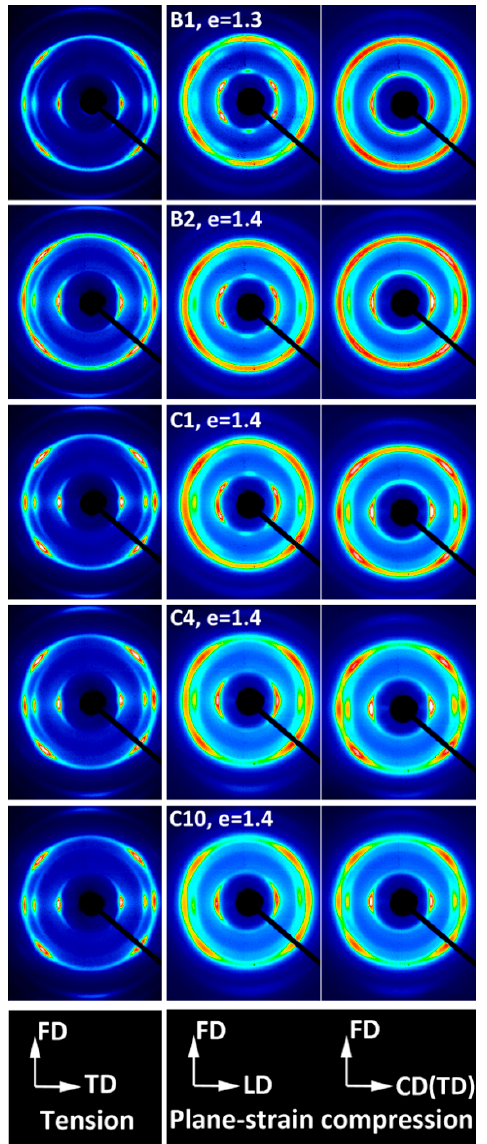
Figure 5. Two-dimensional WAXS patterns recorded for samples of the studied homo- and copolymers deformed to high strain (indicated) in tension (left column) or in plane-strain compression (middle and right column). FD, the tensile direction or the flow direction (in compression); TD, the transverse direction; LD, the loading direction in compression; CD, the constrained direction in compression, equivalent to TD in tensile specimen.